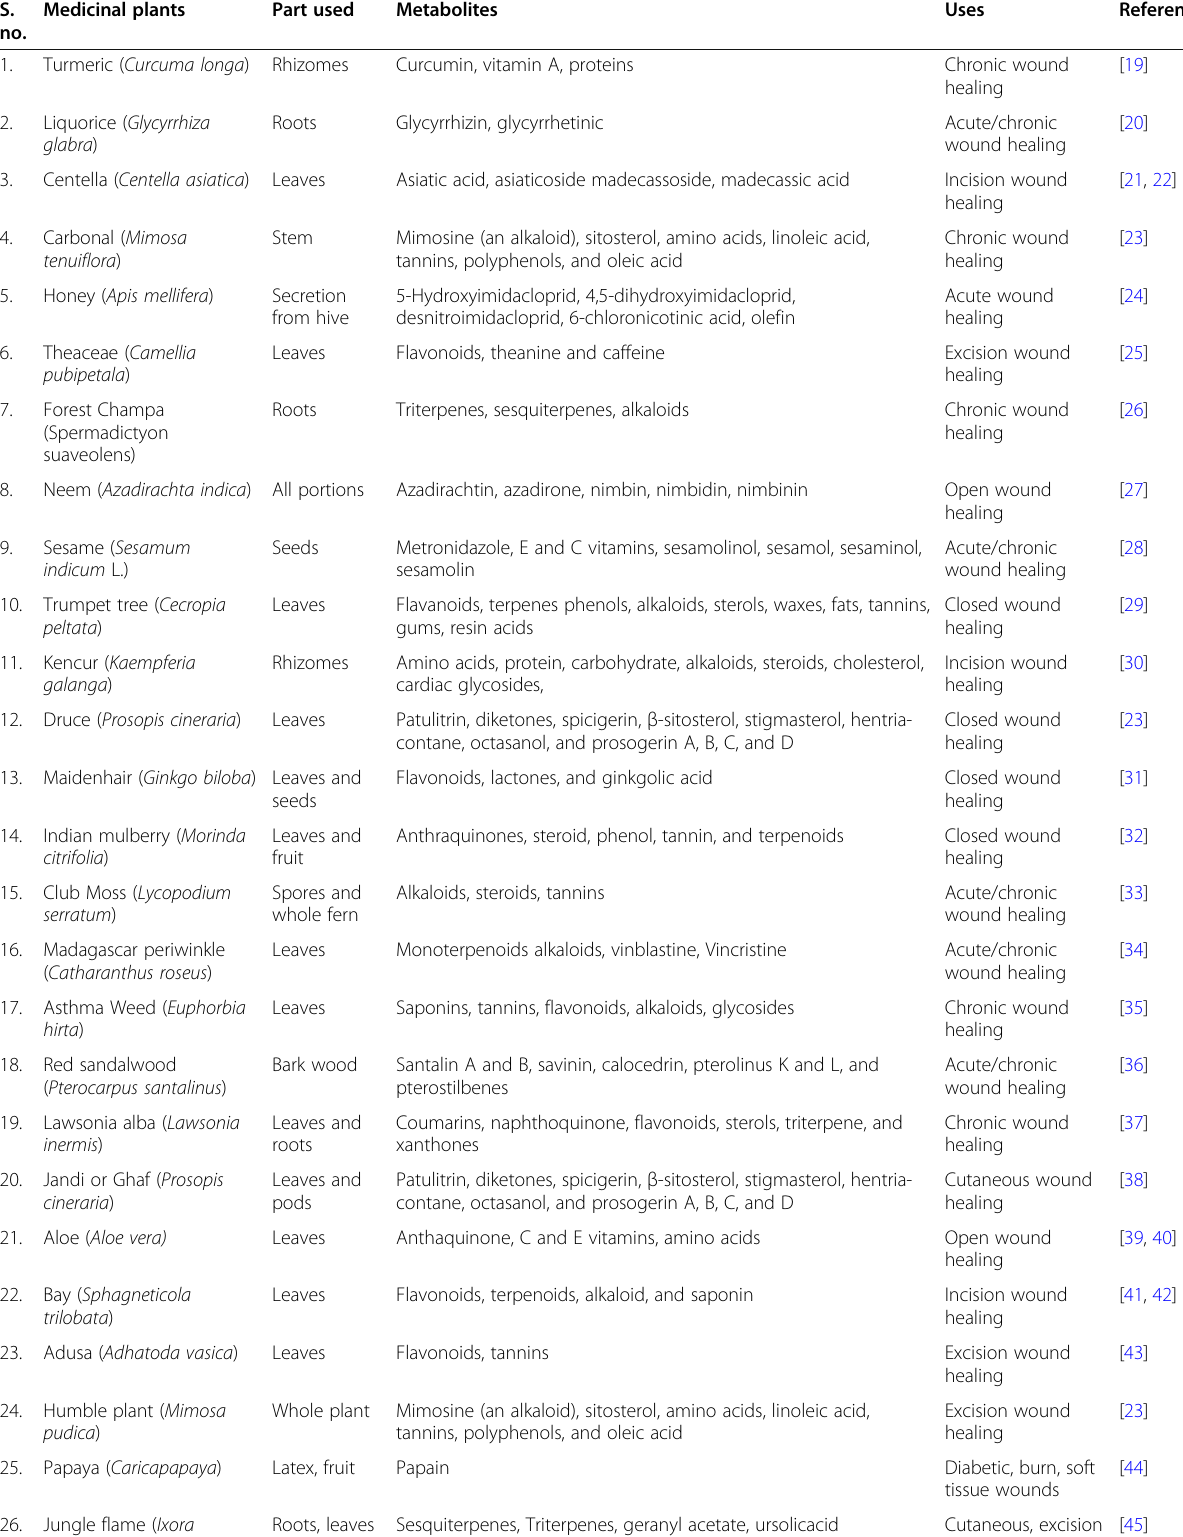
Table 1 Medicinal plants and their metabolites used for treating different types of wounds S. Medicinal no.